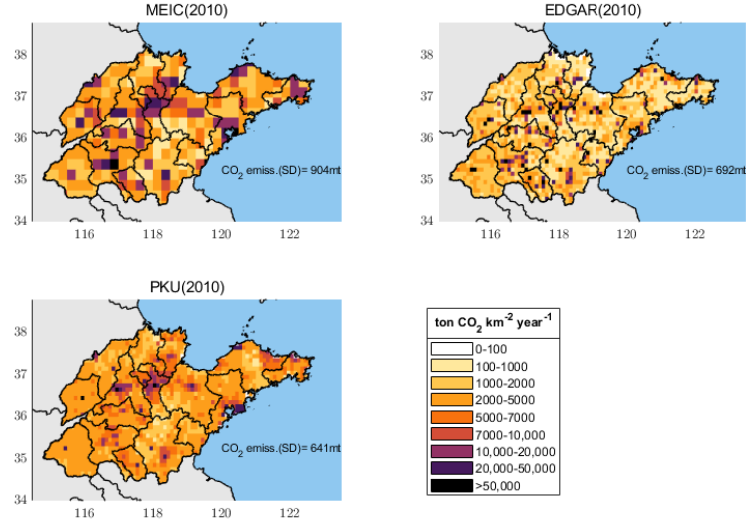
Figure 2. The CO 2 emission distribution for Shandong province in 2010 from MEIC, EDGAR, and PKU-CO 2 .